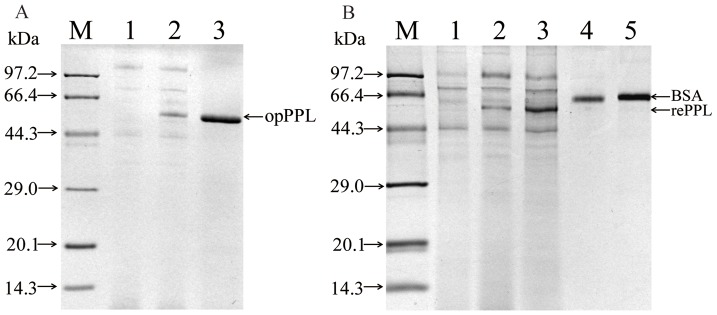
SDS-PAGE identification of opPPL expressed in P.pastoris and comparison of recombination PPL yield.(A) Identification of opPPL expressed in P.pastoris by 12% SDS-PAGE. Lane M, molecular markers; lane 1, crude supernatant from control pPICZαA; lane 2, crude supernatant from opPPL-13; lane 3, purified opPPL. (B) Comparsion of recombination PPL yields. Lane M, molecular markers; lane 1, crude supernatant from control pPICZαA(10 µl); lane 2, crude supernatant from naPPL/pPICZαA(10 µl); lane 3, crude supernatant from opPPL-13(10 µl); Lane 4, BSA standard protein bands (1 µg); Lane5,BSA standard protein bands (2 µg).